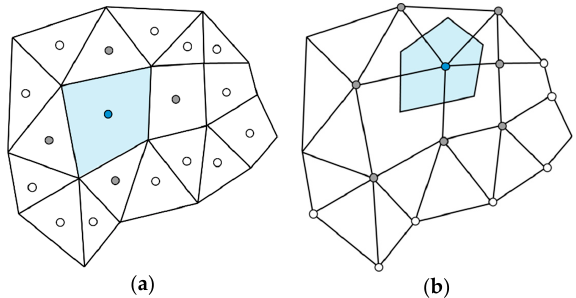
Figure 2. Control cell corresponding to the different variable arrangement. ( a ) Cell-centered; ( b ) vertex-centered.